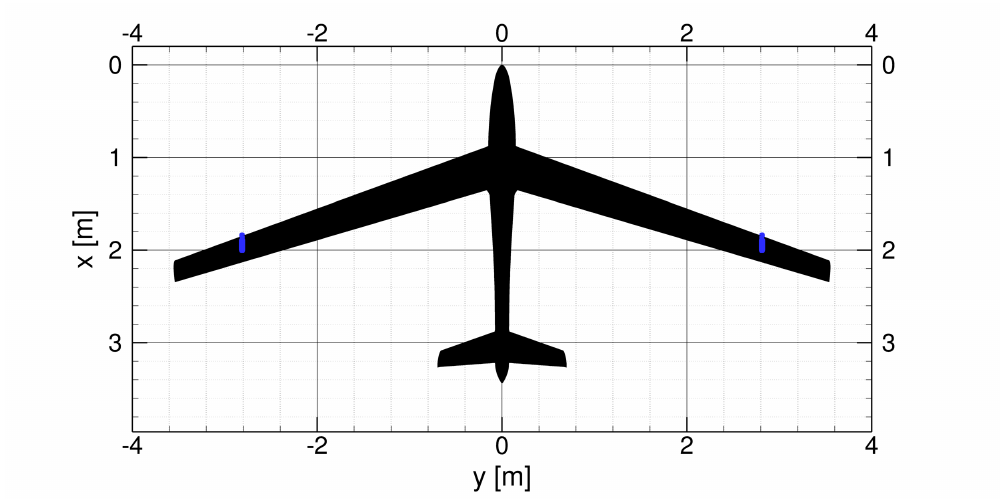
Figure 1. Planform of the FLEXOP UAV based on [19].